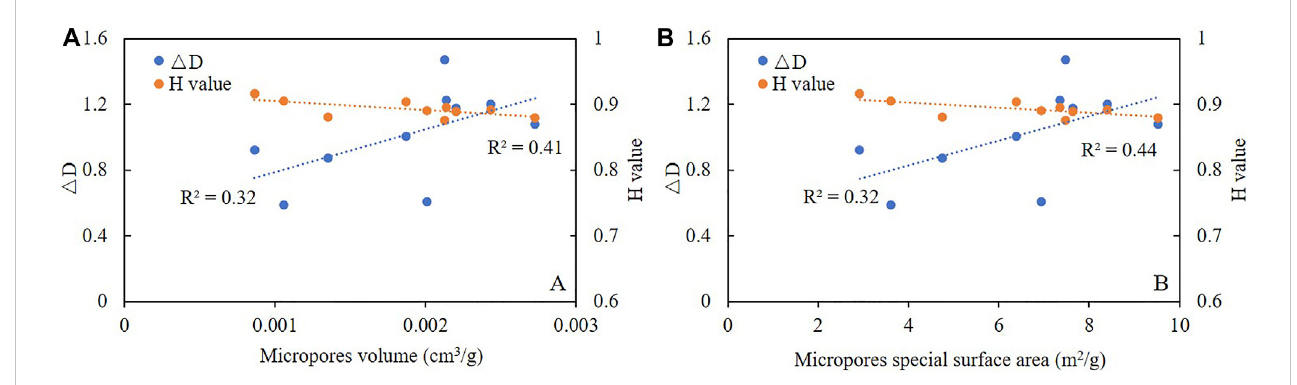
FIGURE 4 Correlation of micropores (A) and meso-macropore (B) volume and Δ D and H values.